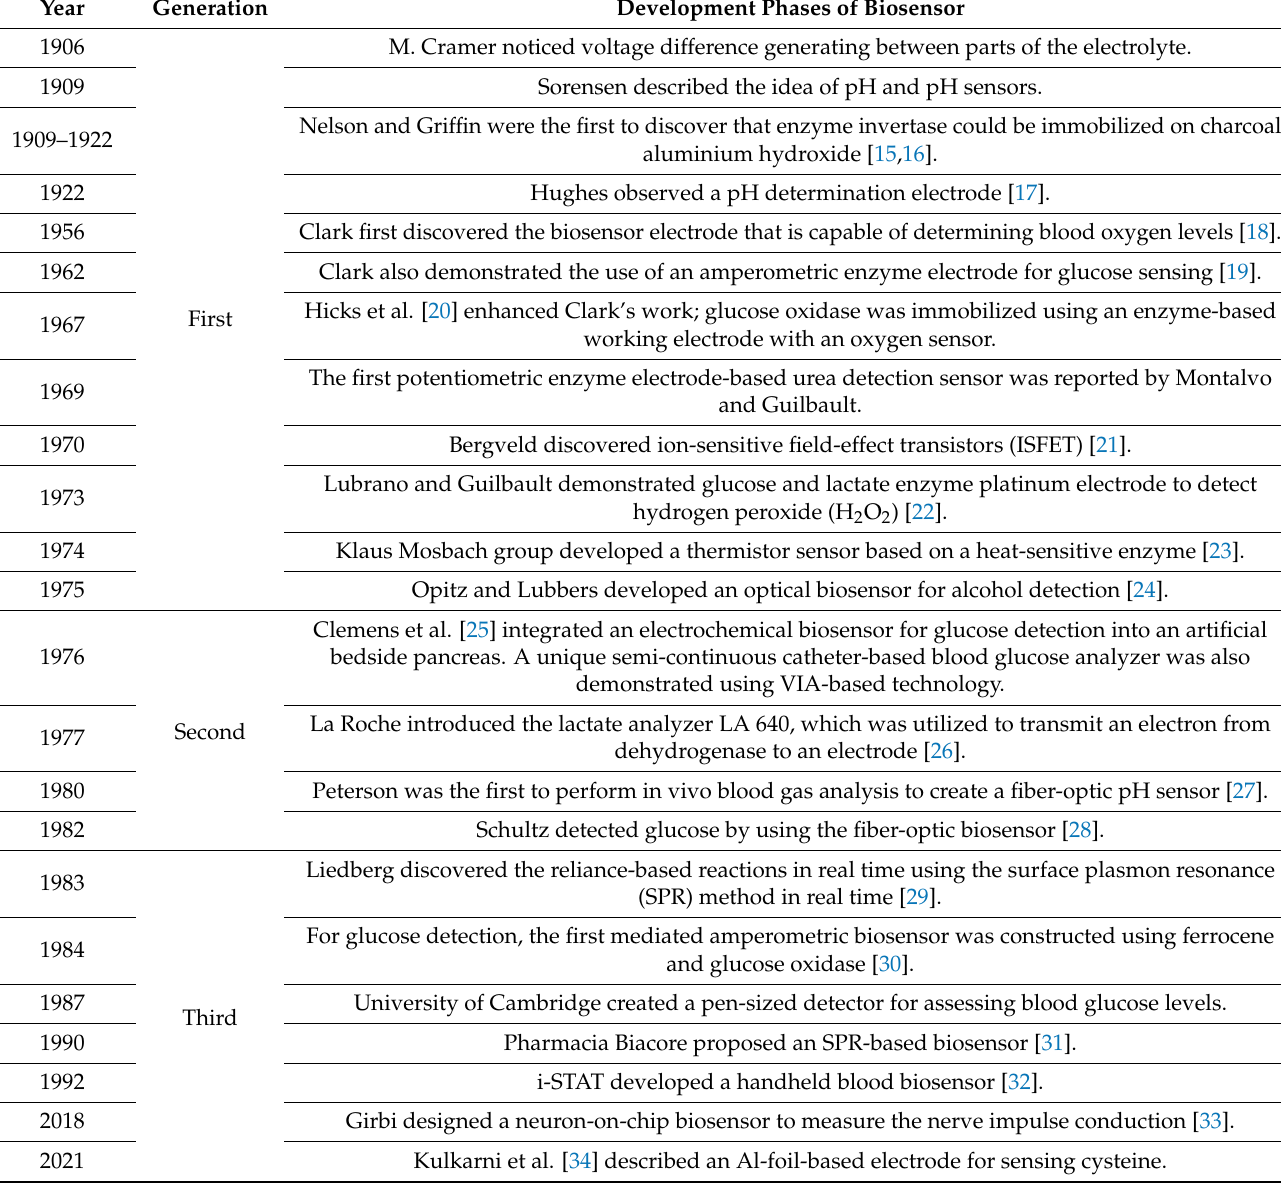
Table 1. Evolution of the development of